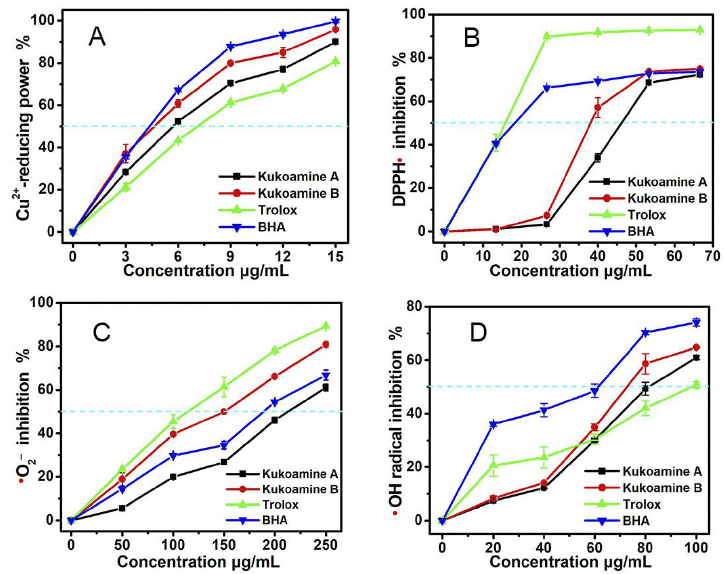
Figure 4. The antioxidant effects of kukoamine A and B in various assays: ( A ) Cu 2+ -reducing assay; ( B ) DPPH•-scavenging assay; ( C ) •O 2− -scavenging assay; ( D ) •OH-scavenging assay. (Each value is expressed as the mean ± SD, n = 3; Trolox was the positive control.).